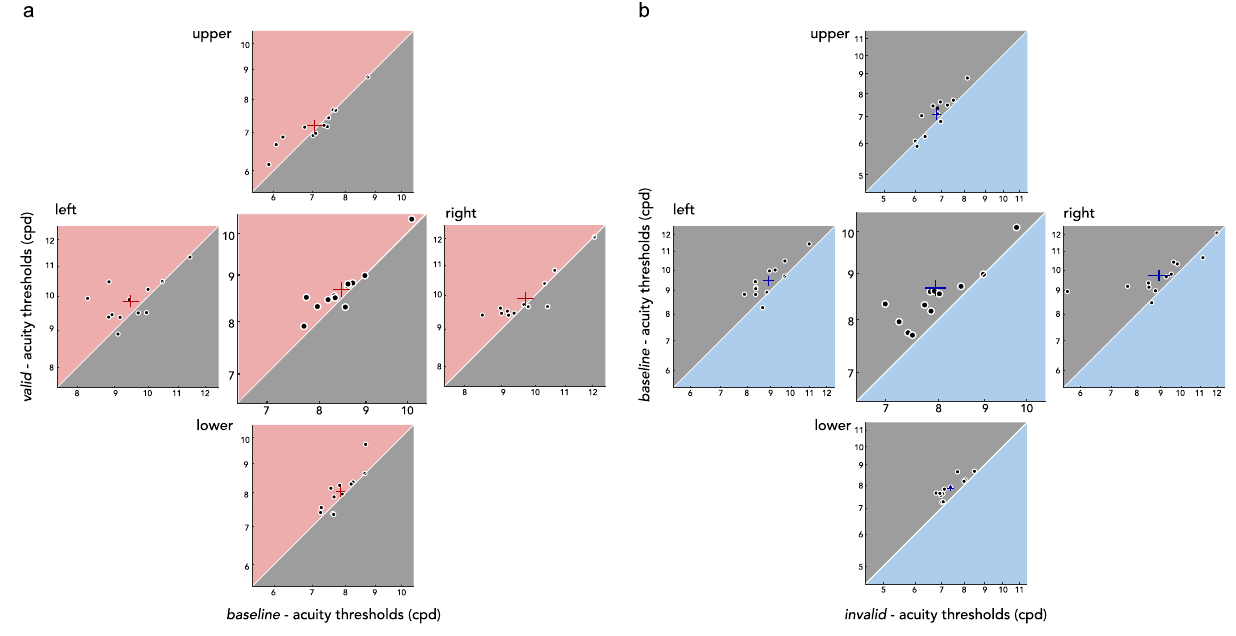
Figure 4. Individual participant’s presaccadic benefits and costs on acuity. (a) Acuity benefits during saccade preparation are demonstrated by plotting the acuity thresholds for the valid condition (y-axis) against the baseline condition (x-axis). (b) Acuity costs during saccade preparation are shown by plotting the acuity thresholds for the baseline condition (y-axis) against the in valid condition (x-axis). For both (a) and (b), the center plots show thresholds collapsed across all four locations. Crosses denote mean ± 1 SEM. Note that the range plotted differs between locations, to account for visual field asymmetries.